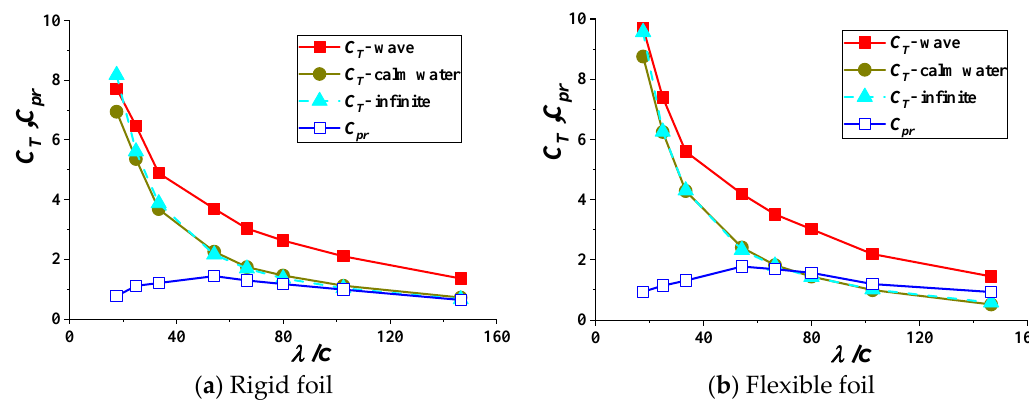
( b ) Flexible foil Figure 9. The percentage of wave energy recovery η r and propulsive efficiency η for the foil versus non-dimensional wave amplitudes. Changes in wave amplitudes have less influence on foil propulsive efficiency η , as shown in Figure 9. From Figure 8 and Equation (9), in waves, increasing a / c not only increases the thrust force coefficient, but also the lateral force and moment coefficients, which means the input and output power of the foil ascend and then change less in η . However, these values in waves are still larger than under calm water. Although the propulsive efficiency of the foil under a free surface is smaller than that in an infinite flow field, the flexible deformation can reduce this decreasing trend, and the flexible foil η in waves is higher than the rigid foil η in the infinite flow fields. However, increasing wave amplitudes reduces the percentage of wave energy recovery η r . To summarize, a higher sea state is beneficial to improving the thrust force of the foil, but not wave energy utilization ability. The flexible deformation can produce a larger thrust force, and have fewer adverse effects of the free surface on reducing the propulsive efficiency of the foil. 4.3. Effect of Wavelengths on the Foil Performance